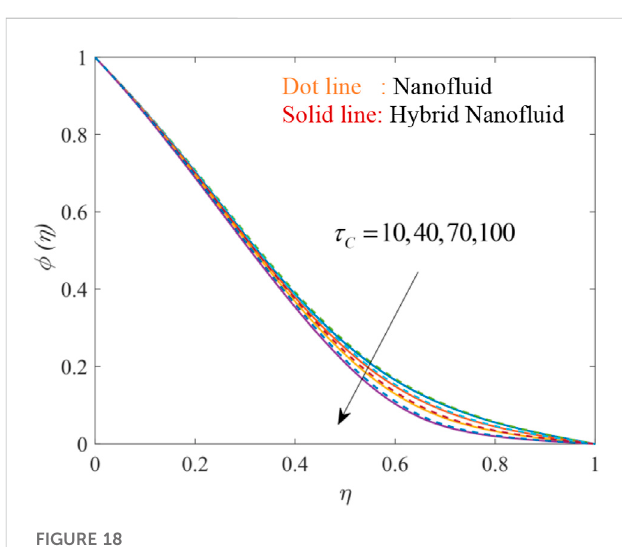
FIGURE 18 Effect of solutal relaxation parameter τ C on ϕ ( η )